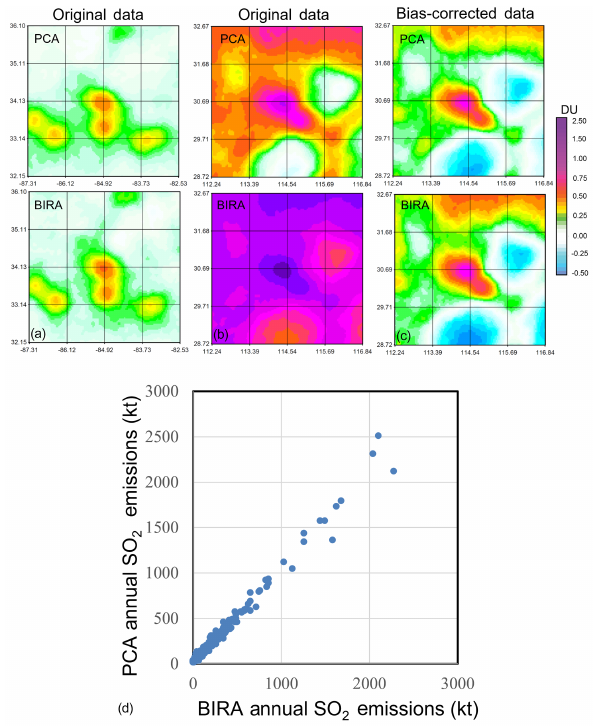
Figure 3. The 2005–2007 mean SO 2 VCD distribution (a) near Bowen power plant (34.13 ◦ N, 84.92 ◦ W), USA, and (b) near Yan- gluo (30.69 ◦ N, 114.54 ◦ E), China, from NASA PCA and BIRA DOAS data. (c) The mean SO 2 distribution near Yangluo with local bias removed as described in Sect. 3. (d) The scatter plot of emis- sions estimated from PCA and BIRA DOAS data for 2005–2007 for about 500 sites analysed in this study. The correlation coeffi- cient between the two data sets is